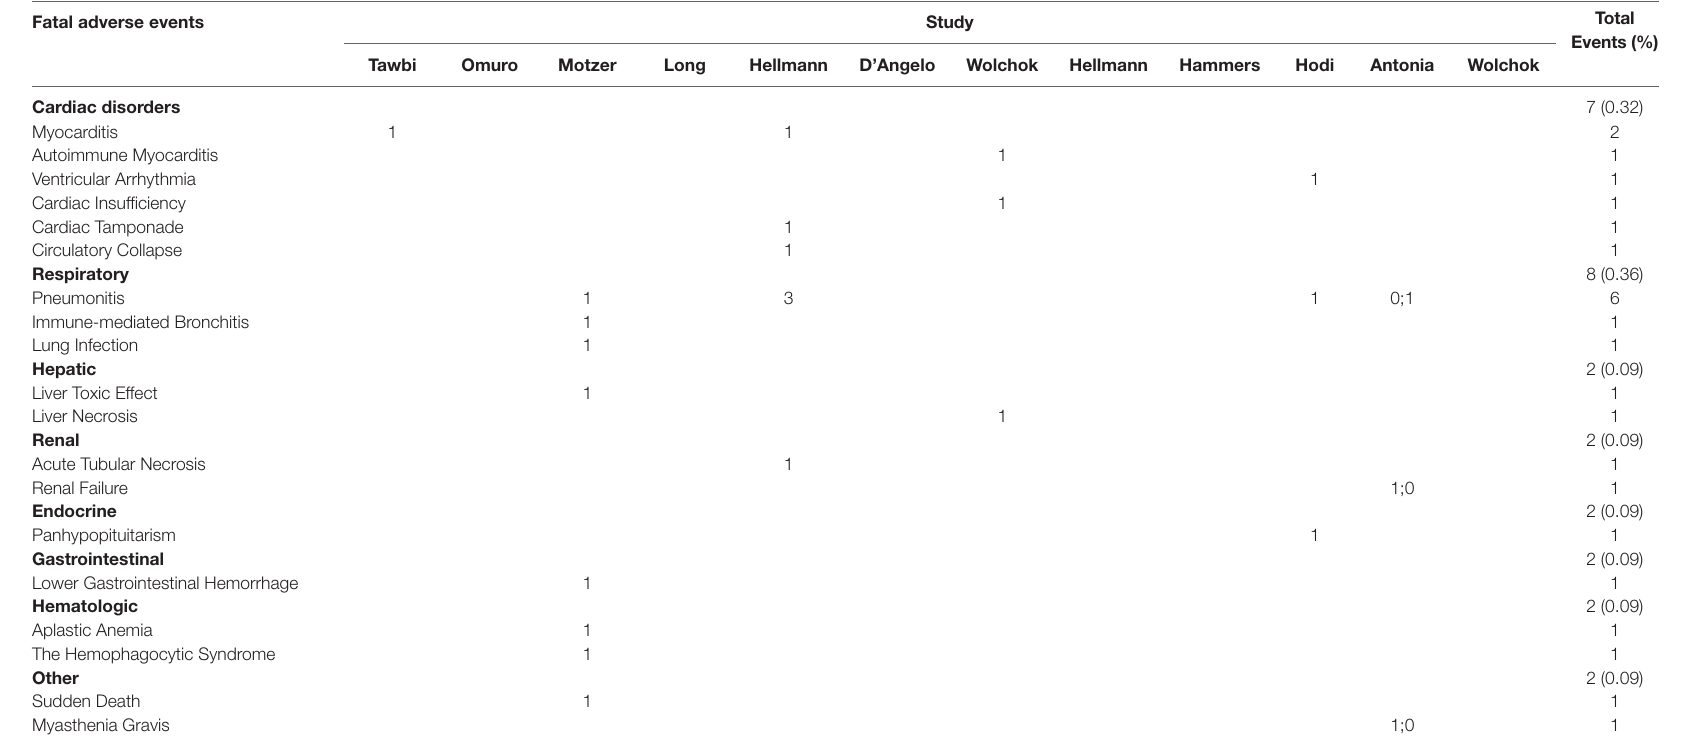
TABLe 4 | Incidence of specific fatal adverse events (grade 5) in included studies (not included ASCO meeting abstracts). Fatal adverse